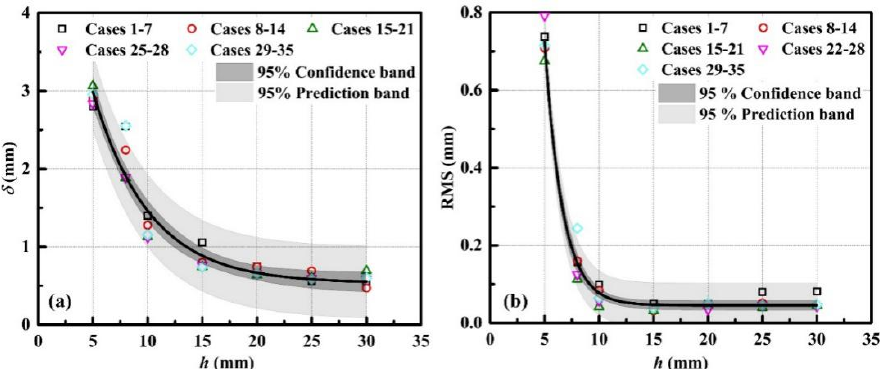
Figure 10. Variations of the liquid film thickness at r = 0 mm. ( a ) variations of the time-average film thickness, ( b ) variations of the RMS in Cases